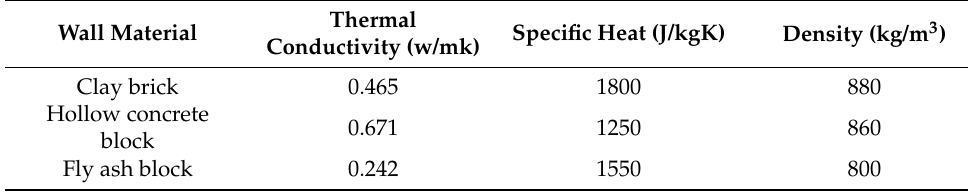
Table 2. Thermal characteristic of wall materials.